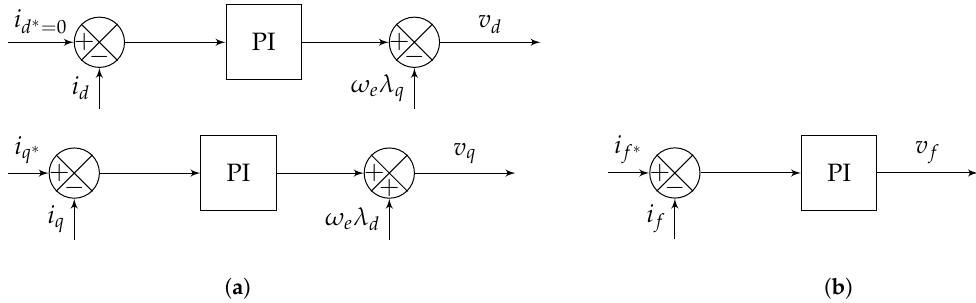
Figure 9. Matlab/Simulink diagram for ( a ) dq -axis current control and ( b ) field current control.